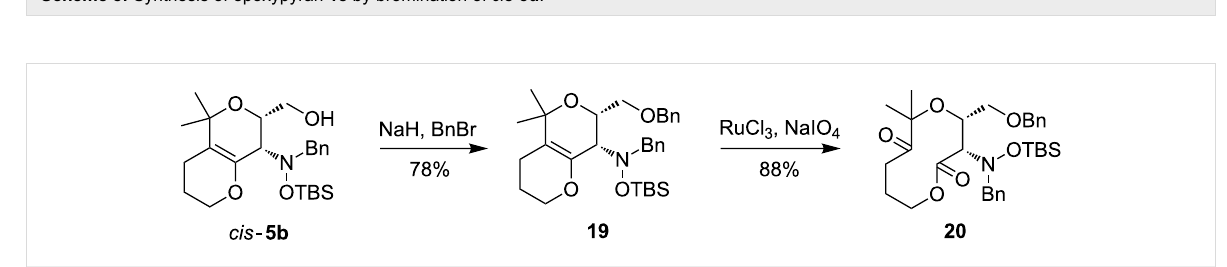
Scheme 8: Synthesis of epoxypyran 18 by bromination of cis - 5d .